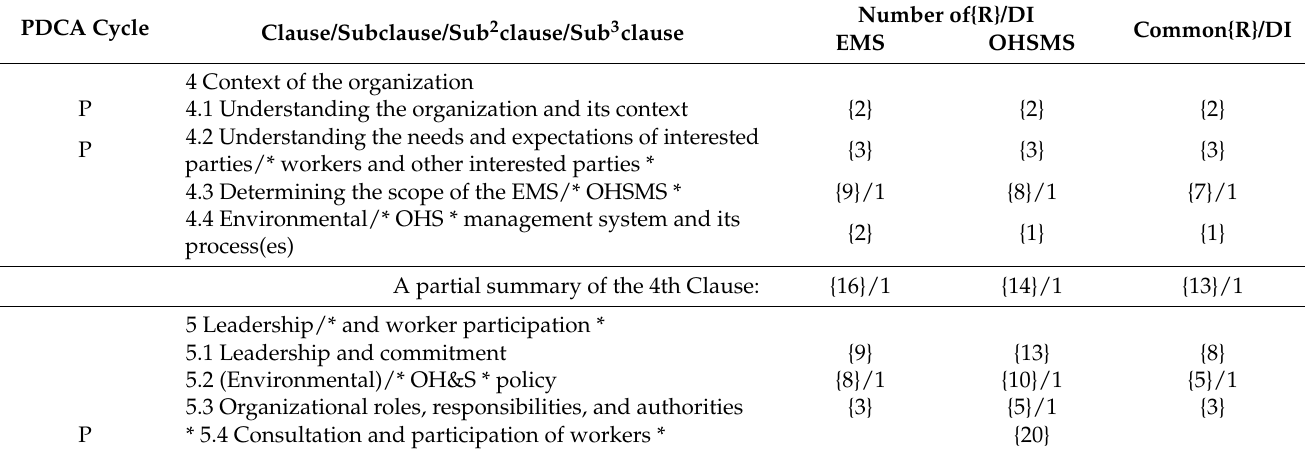
Table 3. Number of requirements, {R}, in composed brackets, and documented information, DI, for the standards ISO 14001:2015 EMS and ISO 45001:2018 OHSMS, and their common {R} and DI. PDCA